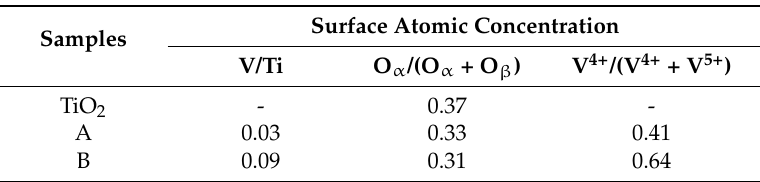
Figure 8. X-ray photoelectron spectrometry (XPS) spectra of ( a ) Ti 2p; ( b ) O 1s; and ( c ) V 2p for two catalysts and self-made TiO 2 support and WO 3 /TiO 2 . Table 3. Surface atomic concentration from XPS spectra in Figure 7.